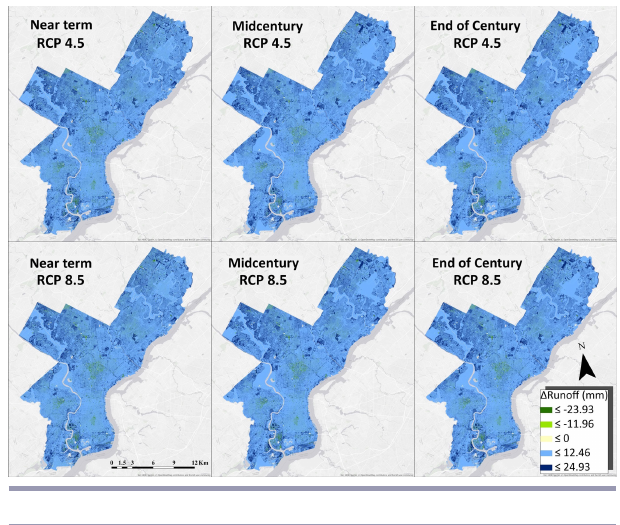
Fig. 1 . Predicted changes in the future amount of runoff (mm) from each climate change scenario during a 95th percentile rain event.